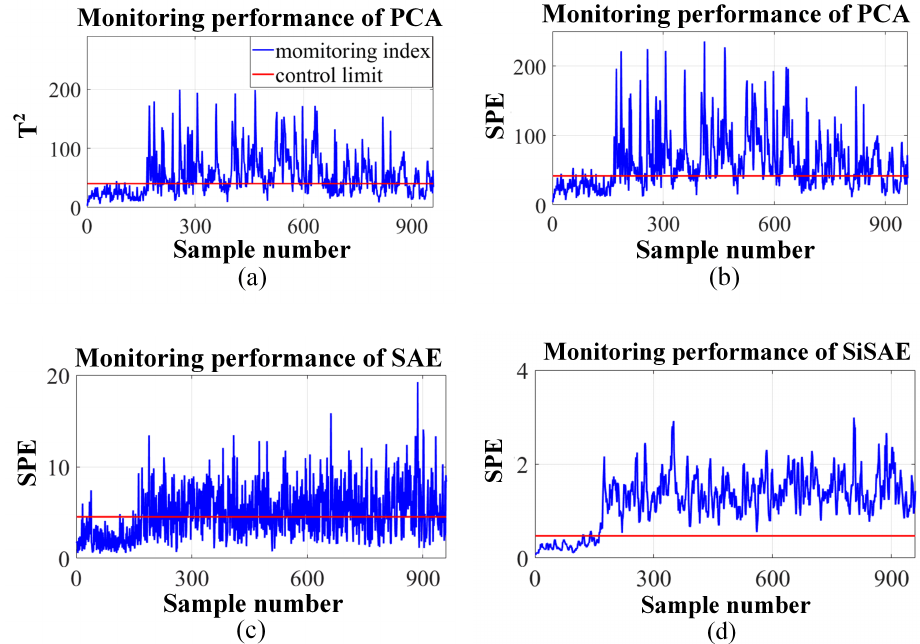
Figure 5. Monitoring results obtained with PCA, KPCA, SAE, and SiSAE for fault 19. ( a ) is the performance of T 2 of PCA, ( b – d ) is the performance of SPE of PCA, SAE, and SiSAE, respectively. In Tables 1 and 2, the DR and FDR of our SPE statistic for the faults are compared with those of other approaches. The findings obtained by monitoring with multiple MSPM and deep network approaches, including PCA, KPCA [24], AE [30], M-DBN [24], LE-DBN [31], SAE, and SiSAE are presented. Table 1. Detection Rate for All Faults in the TE Process. Fault